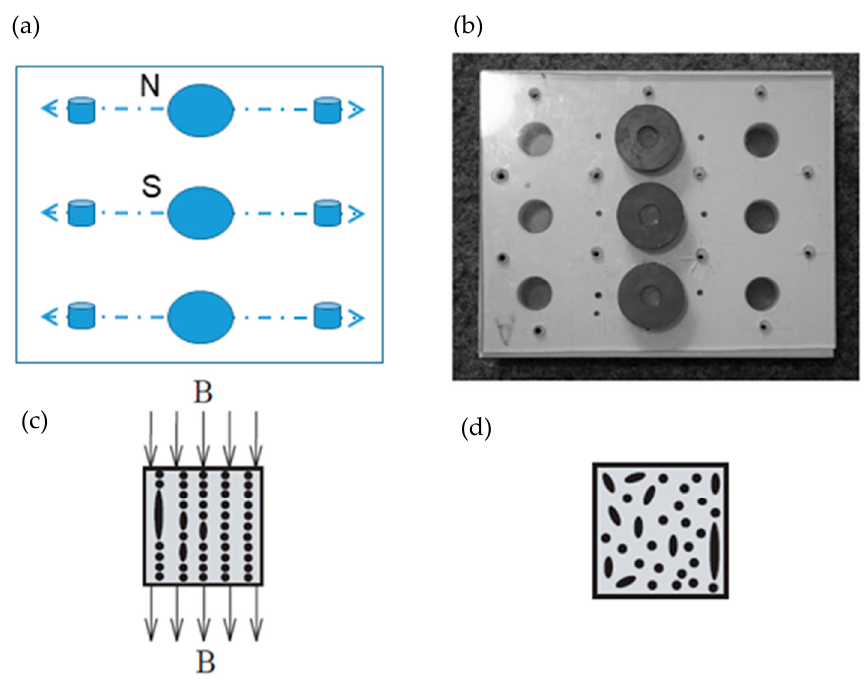
Figure 2. Schematic representation ( a – c ) of the MRE composite fabrication with anisotropic filler distribution with the presence of magnetic field and ( d ) isotropic filler distribution without the presence of magnetic field.